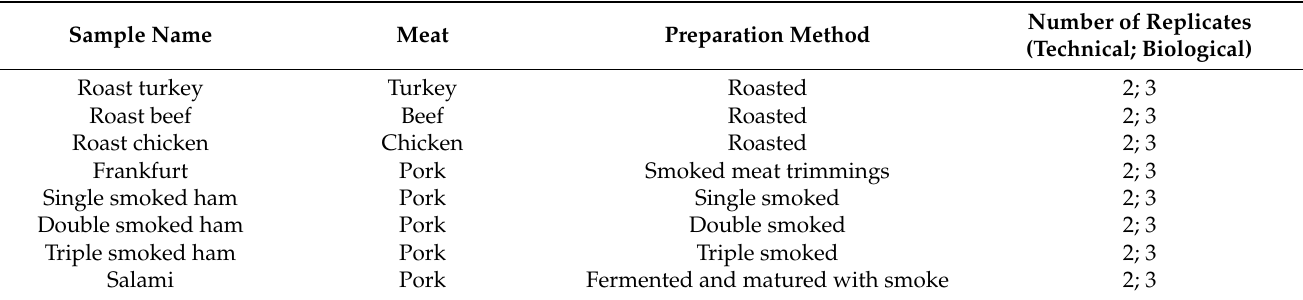
Table 4. Details of meat samples obtained from a local supermarket, including procedures of meat